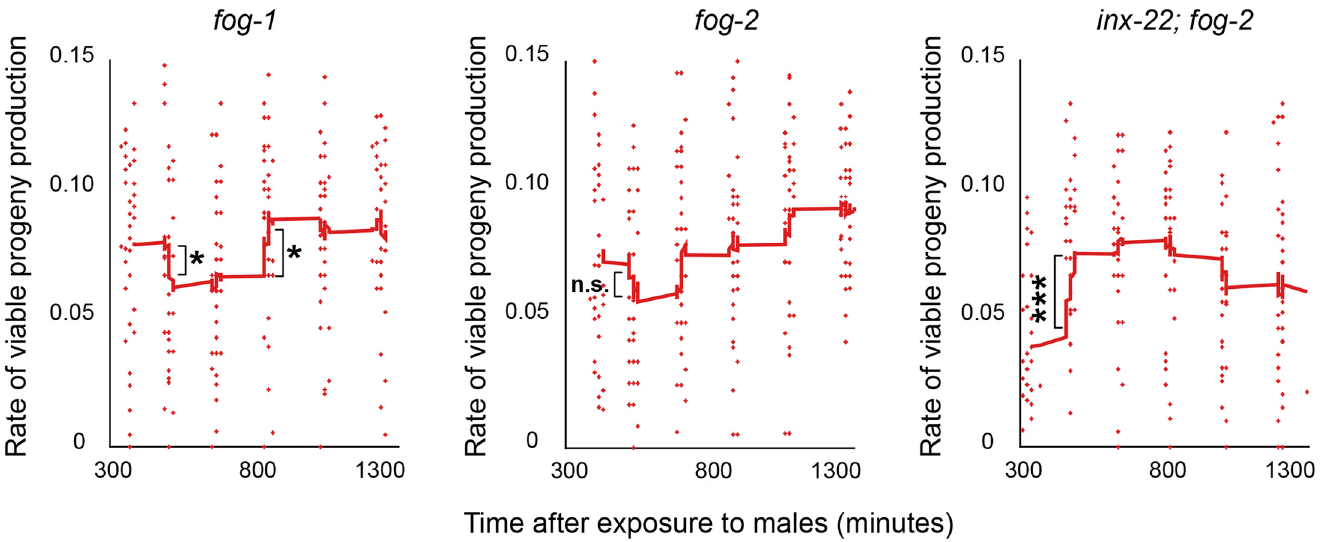
Fig 9. Suboptimal kinetics of response to mating in genotypes and environmental conditions with high gonad dormancy. Early female response to mating on day 3 of adulthood, as assayed by numbers of viable progeny laid per hour. Each point is computed from the number of progeny of one worm over a time window ending at corresponding position on x axis (n = 40 worms per genotype tracked over the time course; some points in the graph overlap). Red lines are moving averages. Error bars represent 83% confidence intervals; asterisks indicate significance of Wilcoxon rank sum test p-value.